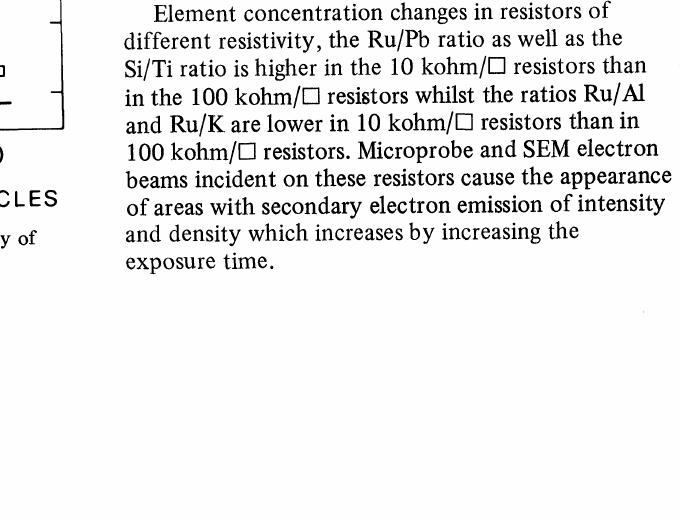
Effect of refiring on the sheet resistivity of SRD Plessey resistors.